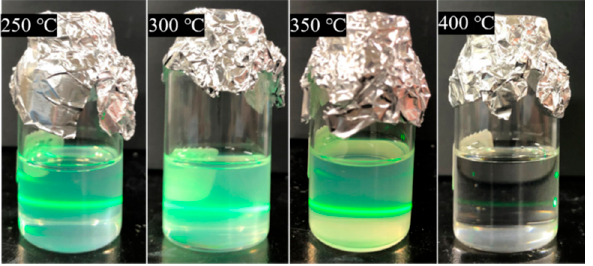
Figure 6. Photographic images of the PHA-modified ZrO 2 nanoparticle dispersions in toluene synthesized at 250, 300, 350, and 400 °C.